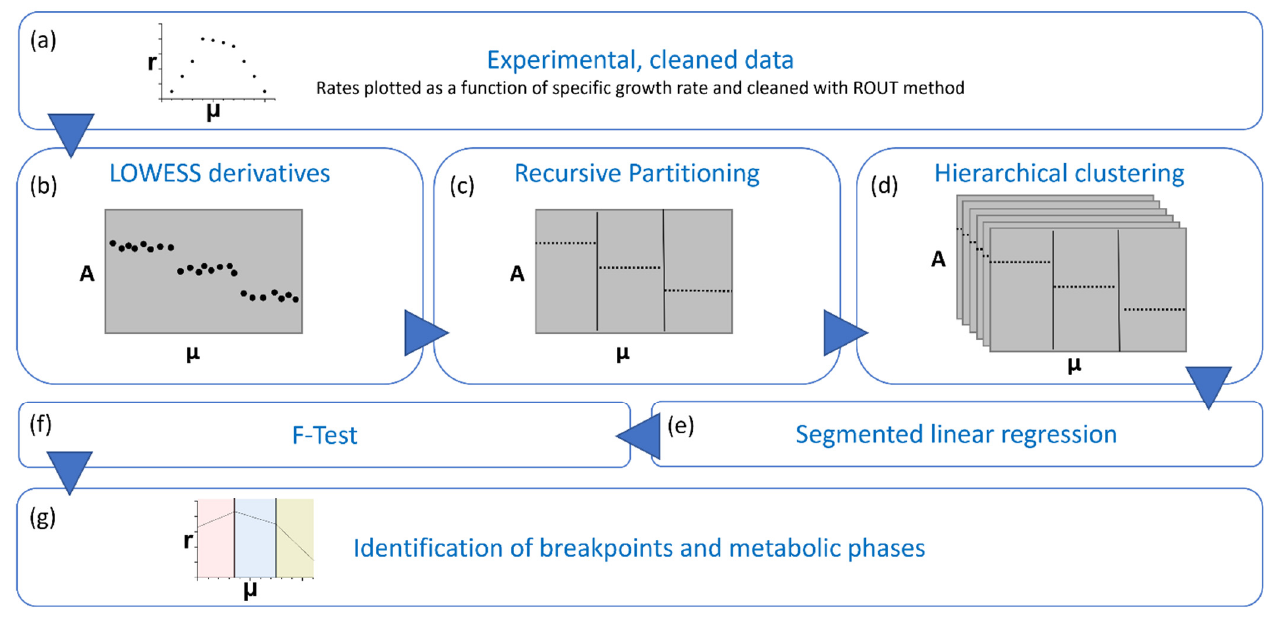
Figure 2. Workflow for identification of metabolic phases with the segmented modeling approach (modified process of Yahia et al. [14]). ( a ) Raw experimental data of specific rates were plotted as a function of specific growth and then were cleaned with the ROUT method. ( b ) The data were smoothed with the LOWESS method and the derivatives of LOWESS were calculated. ( c ) Recursive partitioning was used to split all calculated derivatives of each metabolite into sub-populations. ( d ) Similar breakpoints were identified with hierarchical clustering. The final number of clusters selected was chosen as the fi rst knee point in the linkage function. ( e ) Segmented modeling is a method in which the speci fi c growth rate is partitioned into intervals and each interval is modelled using linear regression. The breakpoints used in the segmented linear regression were the values of the two line segments intersections. ( f ) The segmented modeling process was analyzed with the F- Test to avoid over fi tt ing and to reduce the number of breakpoints if this makes the model statistically superior. ( g ) With the F-Test, the fi nal number of breakpoints and therefore the metabolic phases are identi fi ed.